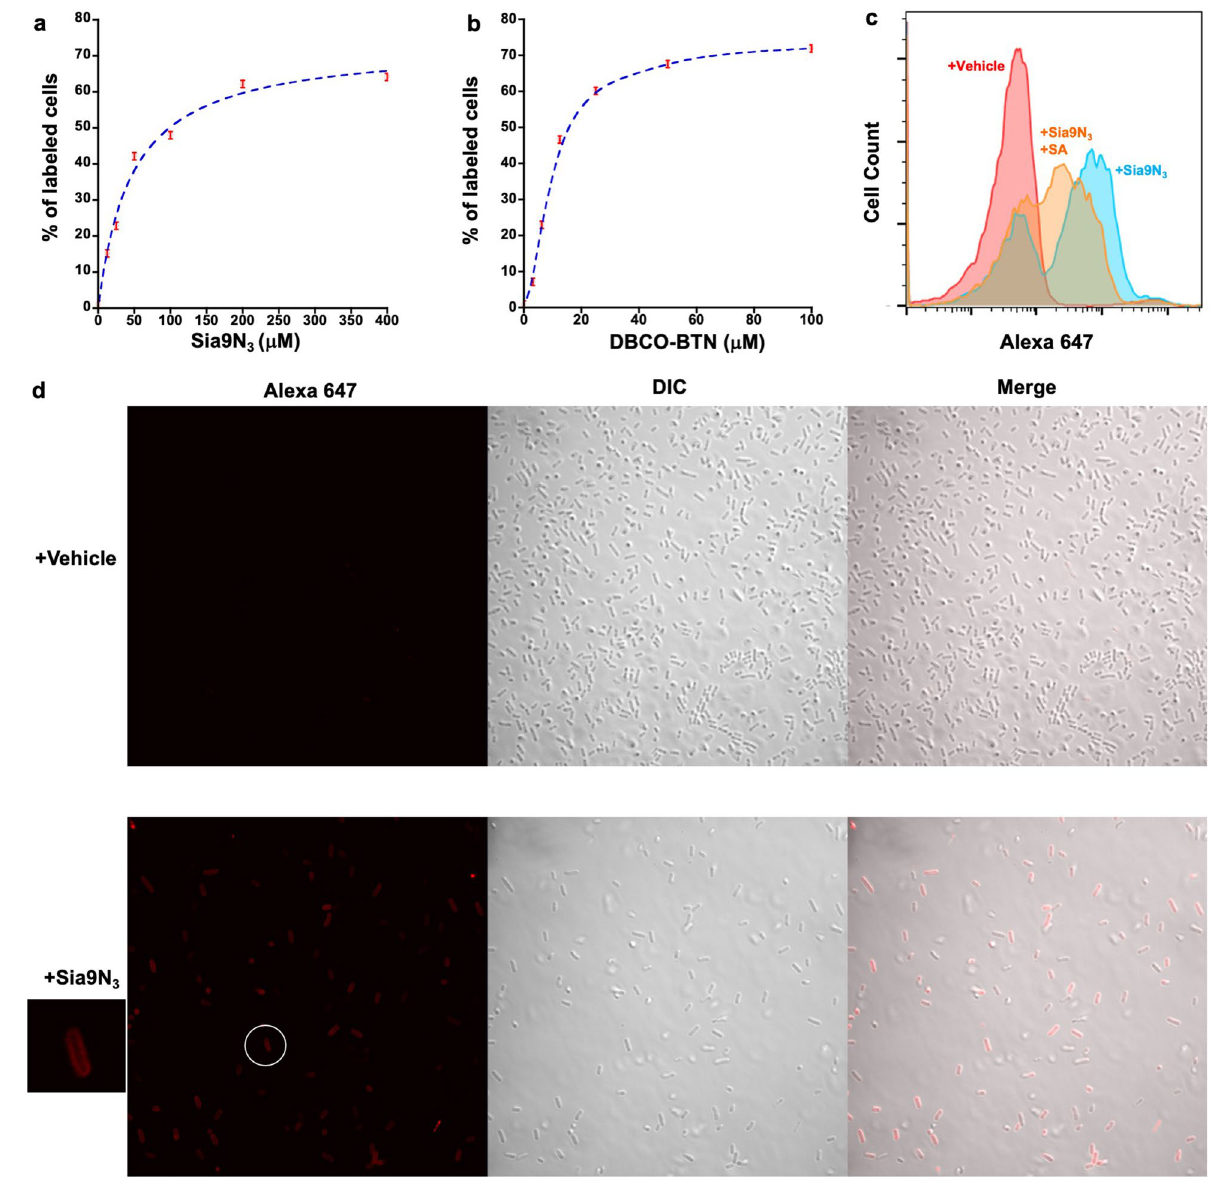
Figure 2. Characterization of Sia9N 3 induced fluorescence staining with flow cytometry and confocal fluorescence microscopy. Labeling of SA-presenting microbes is Sia9N 3 ( a ) and DBCO-BTN ( b ) dose- dependent. ( c ) Addition of excess natural sialic acid (SA) partially competed for fluorescence labeling ([Sia9N3]: 200 μM, [SA]: 1000 μM). ( d ) Confocal fluorescence microscopic imaging showed that Sia9N 3 induced fluorescence labeling on the bacterial cell